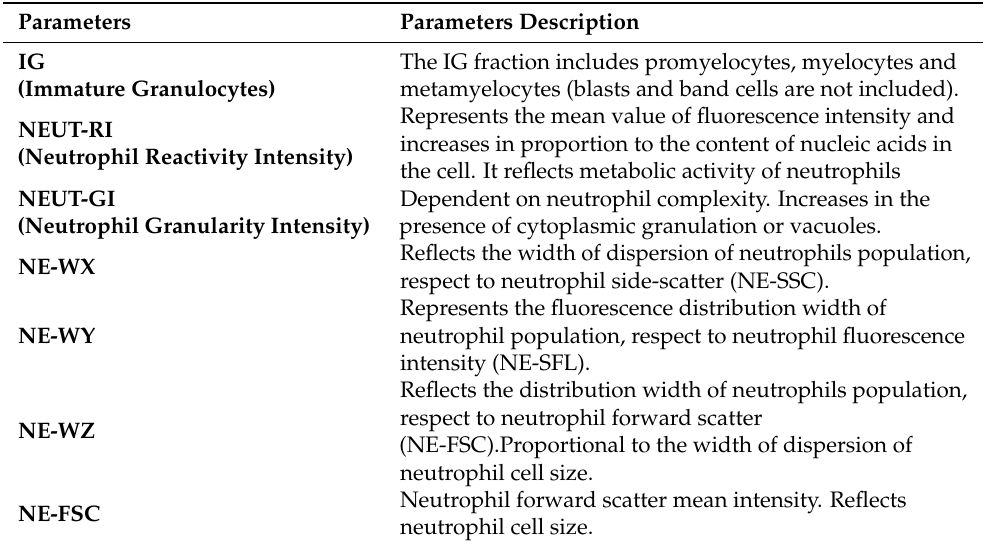
Table 1. Description and significance of new neutrophil